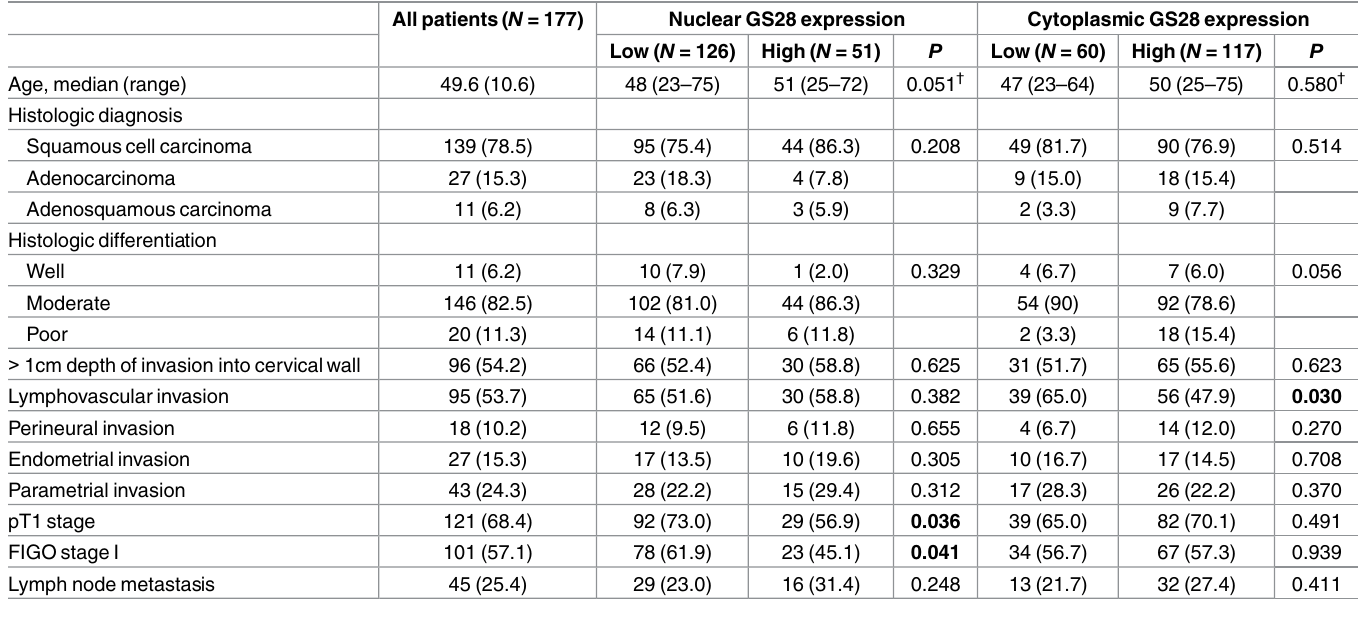
Table 1. Relationship of subcellular expression of GS28 withclinicopathologicalfeaturesof cervical cancertissues. All patients( N =